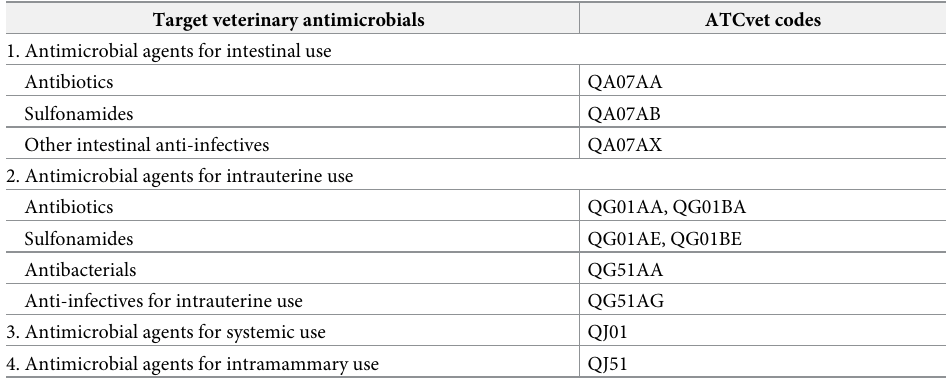
Table 1. The scope of target antimicrobials intended for use in food-producing animals. Target veterinary